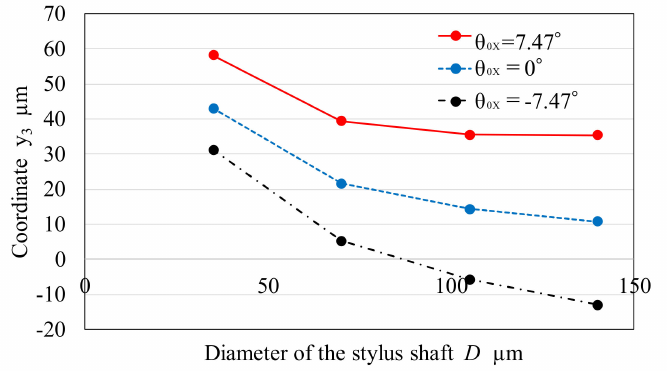
Figure 7. Schematic diagram of the stylus shaft diameter considered the curvature radius of elliptical shape of oblique cross-section of stylus at the laser beam oblique irradiation position of stylus surface.